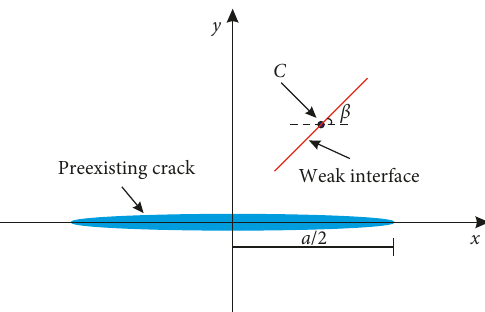
Figure 16: Location map of weak structural plane and crack.